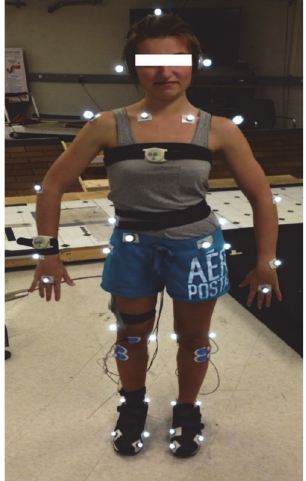
Figure 1: The picture of placement of reflective marker, inertial sensors, and